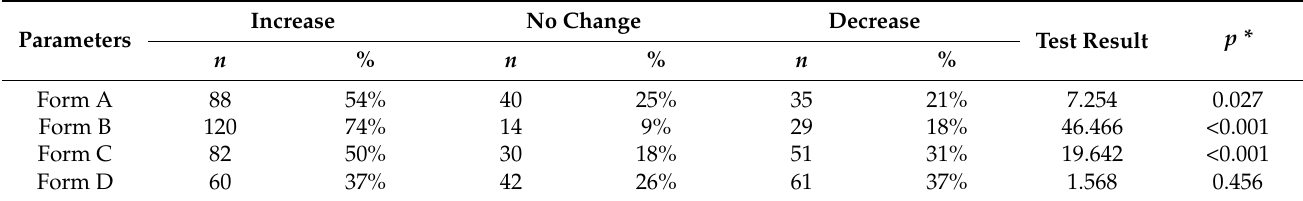
Table 2. Effects of treatment on percentage of sperm motility forms in the ejaculate.